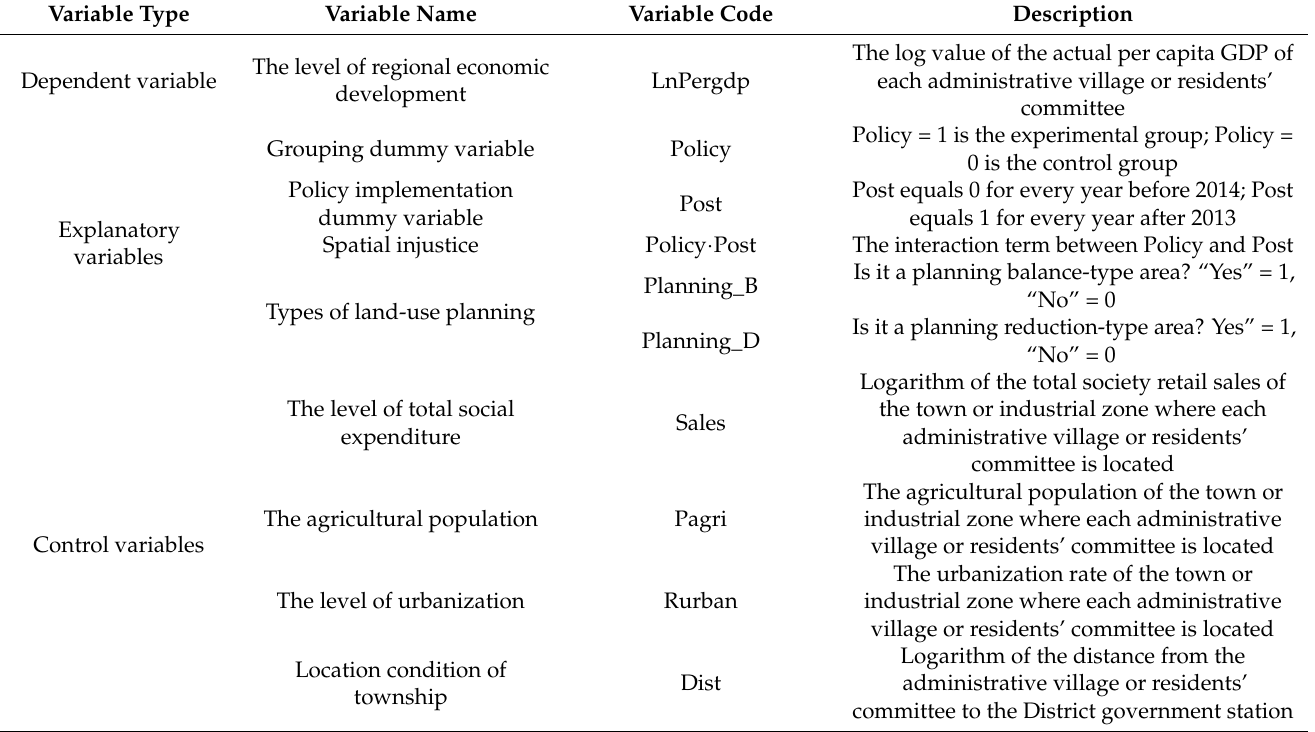
Table 1. Description of main model variables.